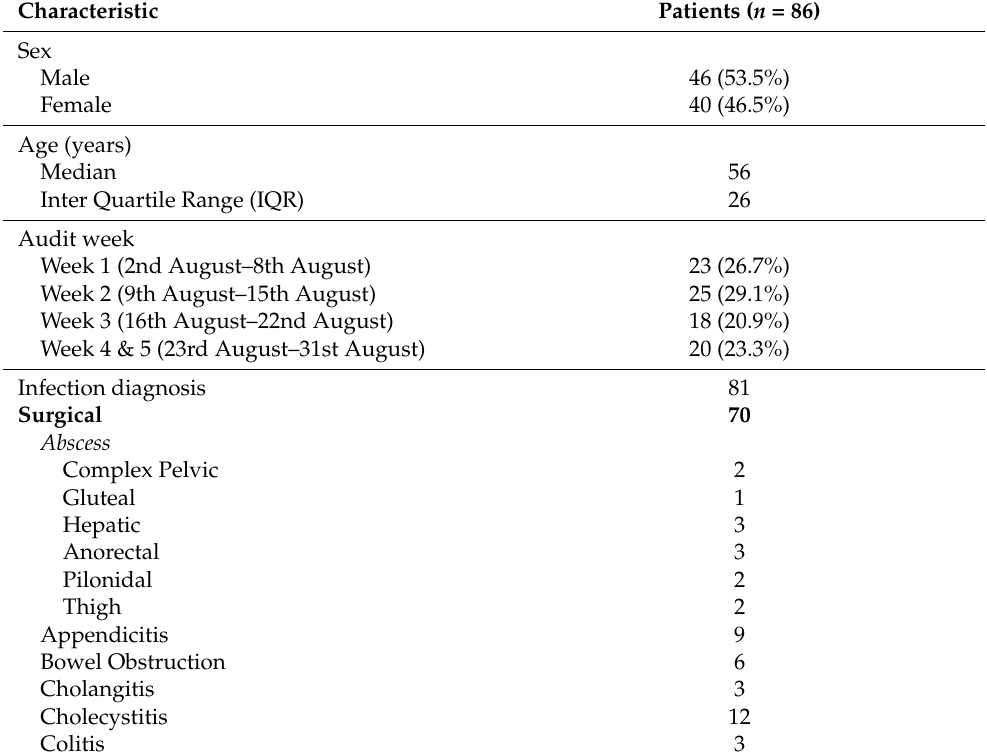
Table 1. Summary of patient